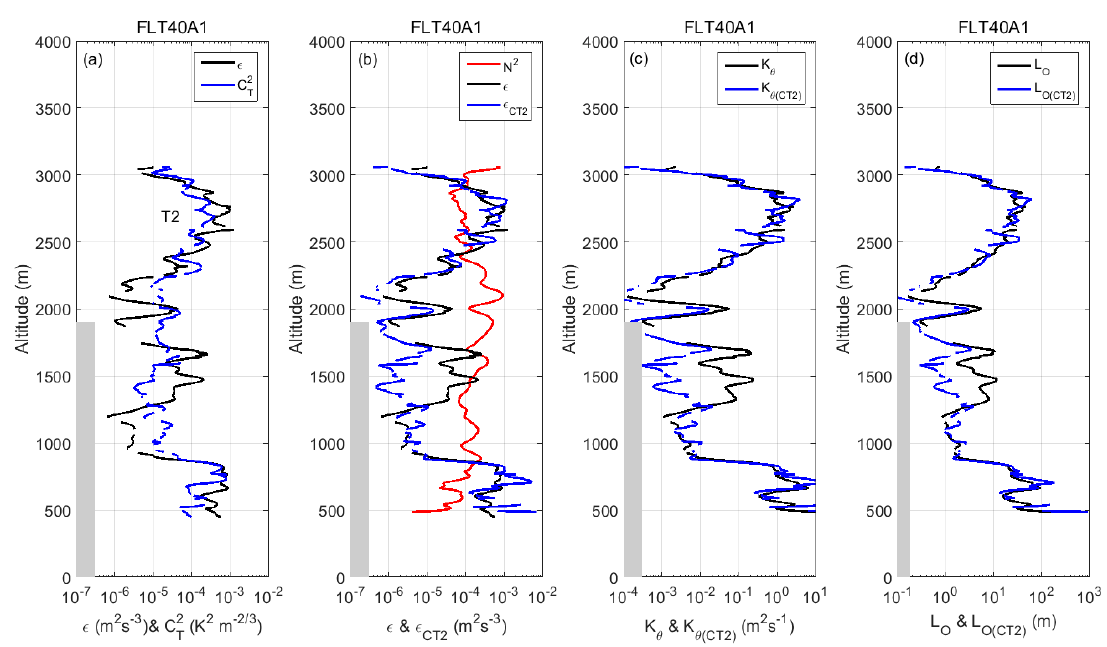
Figure 11. The same as Figure 9 for FLT40A1. Here, the gray shaded areas does not show CBL range but the height range where air was cloudy (saturated). “T2” refers to a turbulent layer discussed in the text.